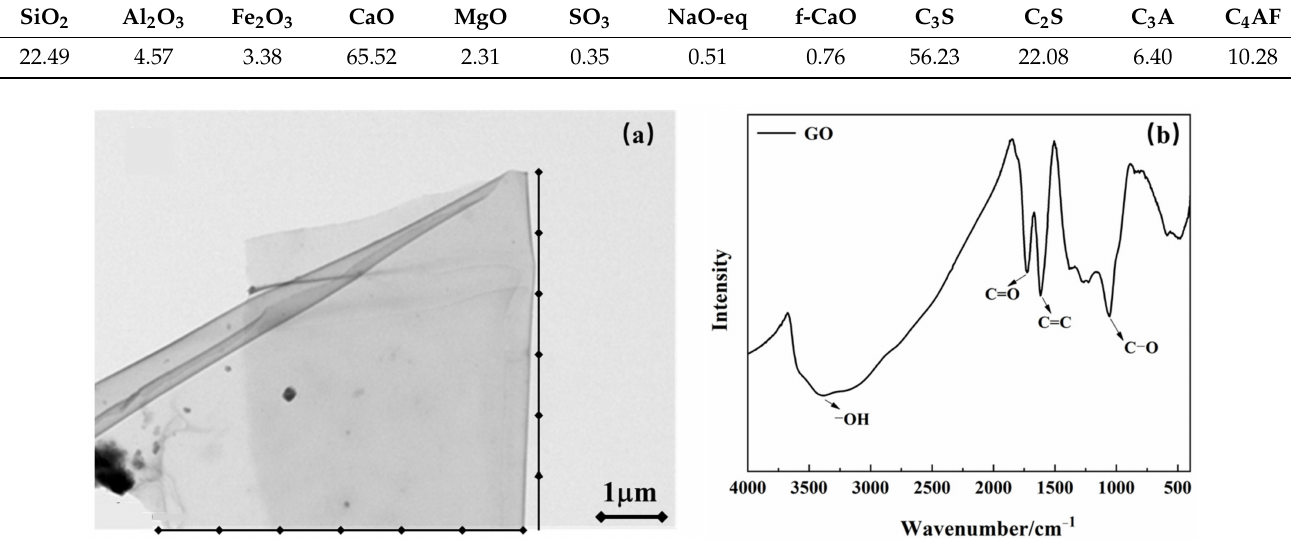
Table 1. Chemical and mineral composition of reference cement clinker (%).